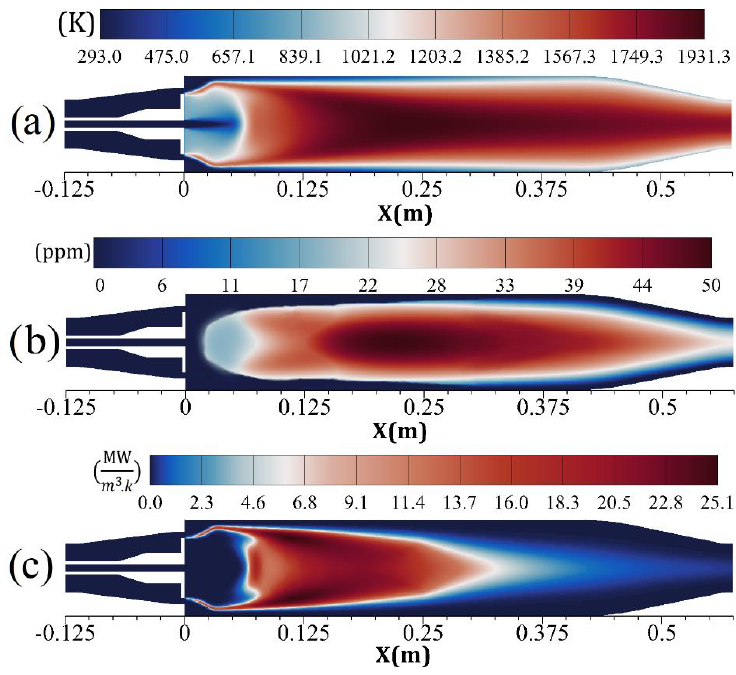
Figure 11. Distributions of ( a ) mean temperature, ( b ) NO concentration and ( c ) total entropy gener- ation rate along mid-plane (Z = 0).